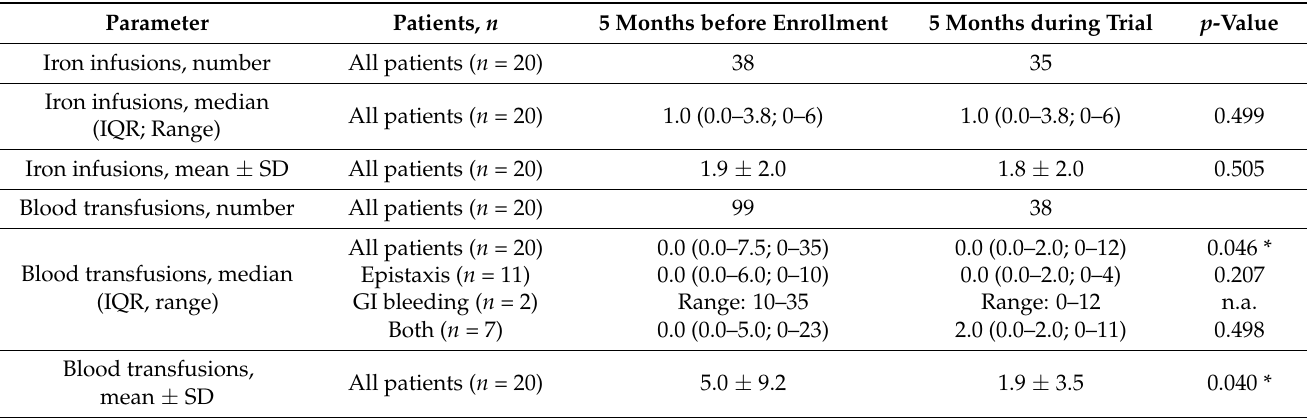
Table 4. Outcomes: iron infusions and blood